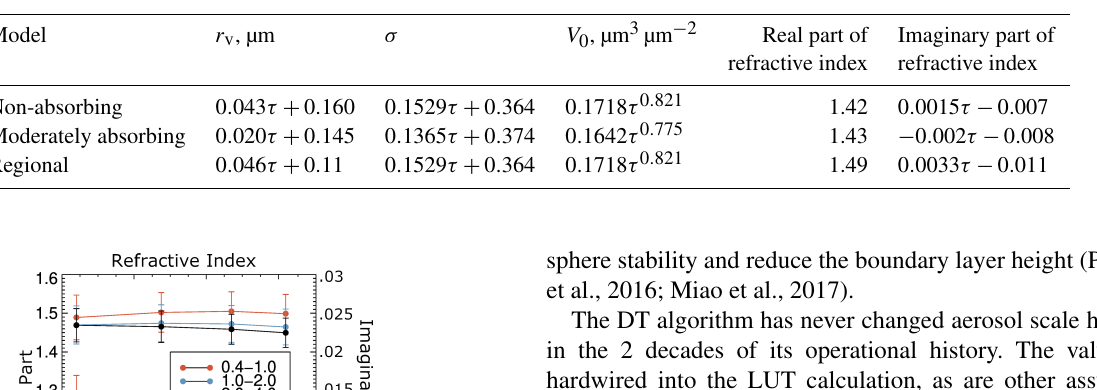
Table 1. Optical properties of the aerosol model used by the operational DT algorithm over China and the regional model generated in this study using AERONET inversion products. The real and imaginary refractive index is a spectrally dependent quantity. Values in this table are for 0.55µm.